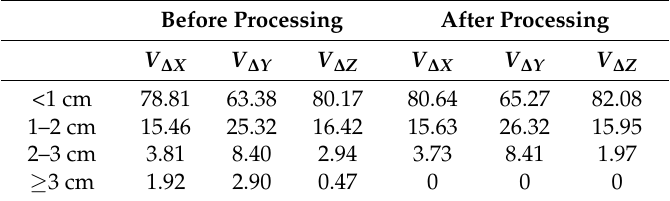
Table 5. Statistics of baseline vectors’ corrections of the spatial GNSS monitoring network (%).